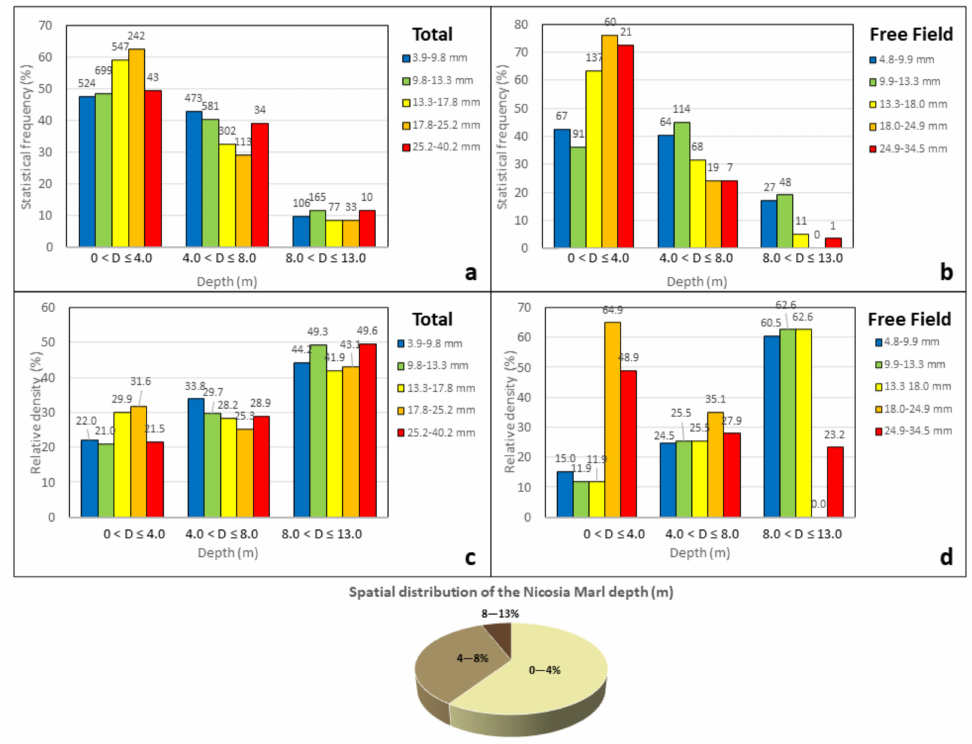
Figure 13. Statistical frequency ( a , b ) and relative density ( c , d ) of the vertical displacement amplitude points as a function of the khaki marl upper boundary depth for total and free field PS